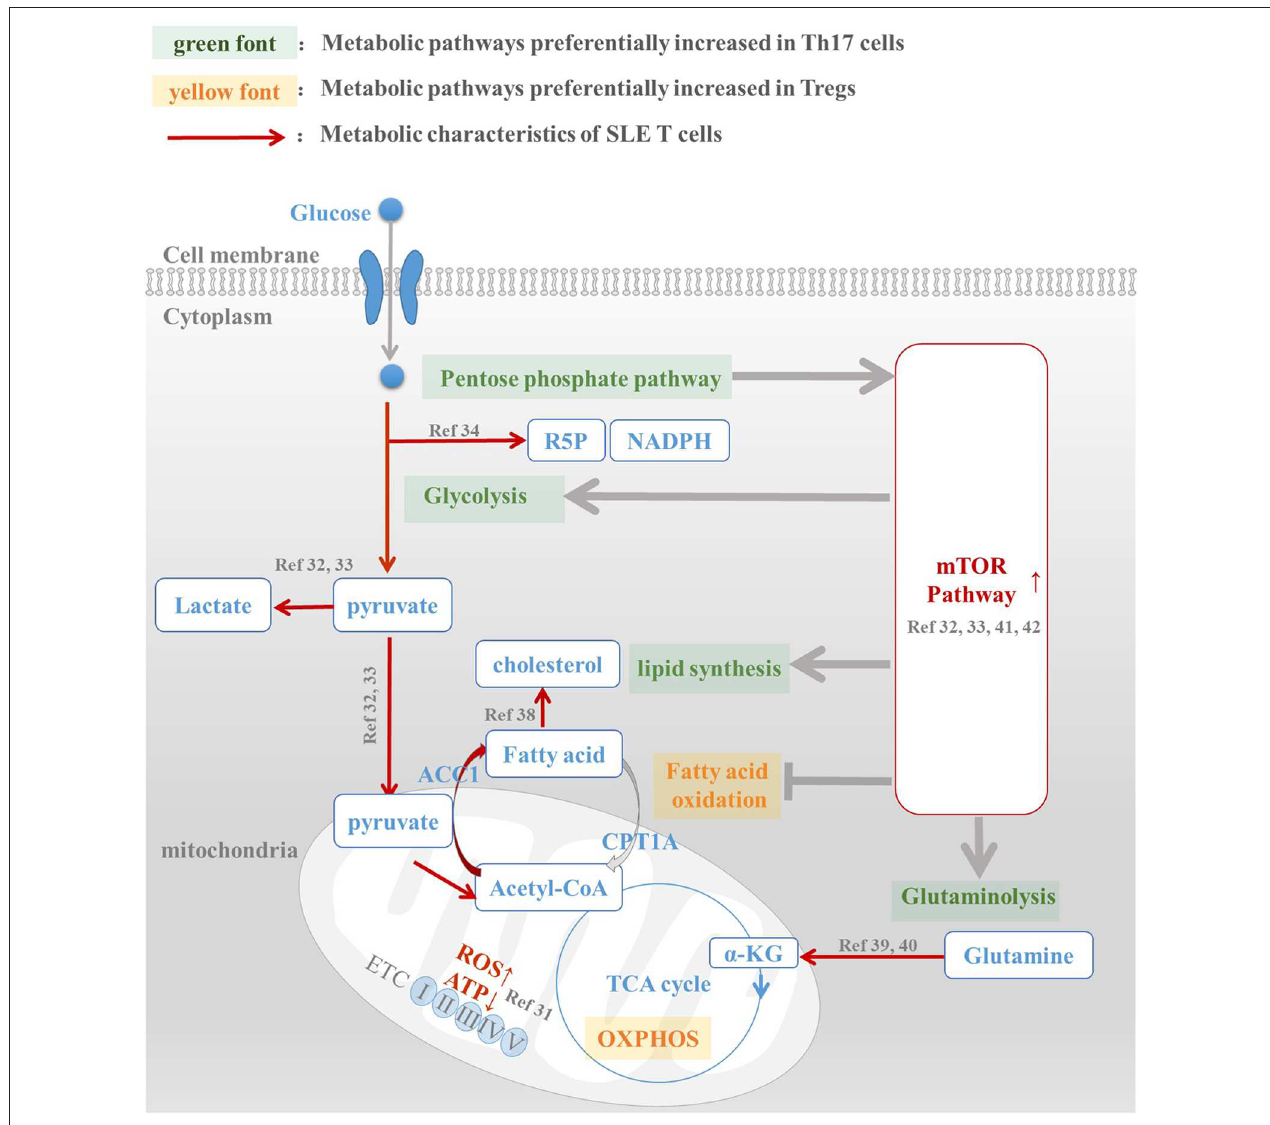
FIGURE 1 | Metabolic abnormalities is the underlying mechanism of Th17/Treg imbalance in SLE patients. Th17 and Treg cells have a distinct metabolic pattern: pentose phosphate pathway, glycolysis, fatty acid synthesis, and glutaminolysis are preferentially increased in Th17 cells, while fatty acid oxidation and oxidative phosphorylation are active in Treg cells. However, metabolic abnormalities of T cells in SLE patients, including enhanced glycolysis, active lipid synthesis, increased glutaminolysis, and high mTOR activation, are all conducive to Th17 differentiation and function. For this reason, we speculated that abnormal T cell metabolism was the mechanism underlying Th17/Treg imbalance in SLE patients. The intervention of metabolic pathways to reprogram T cell metabolic patterns in SLE patients, reduce their overactivated glycolysis and lipid synthesis levels, and promote the oxidation of fatty acids, is expected to reverse the Treg/Th17 imbalance in patients and restore their normal immune